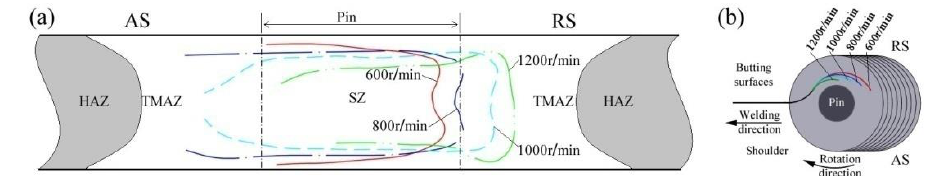
Figure 7. Schematic diagram of: ( a ) the “S” line morphology of the section at different rotational speeds, ( b ) the flow process of plastic metal.